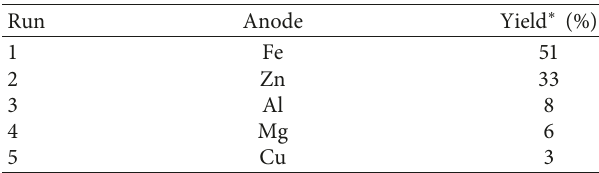
Table 1: Results of the reductive coupling reaction of 2-bro- mooctane with methylvinylketone with various cobalt complex catalysts. Run